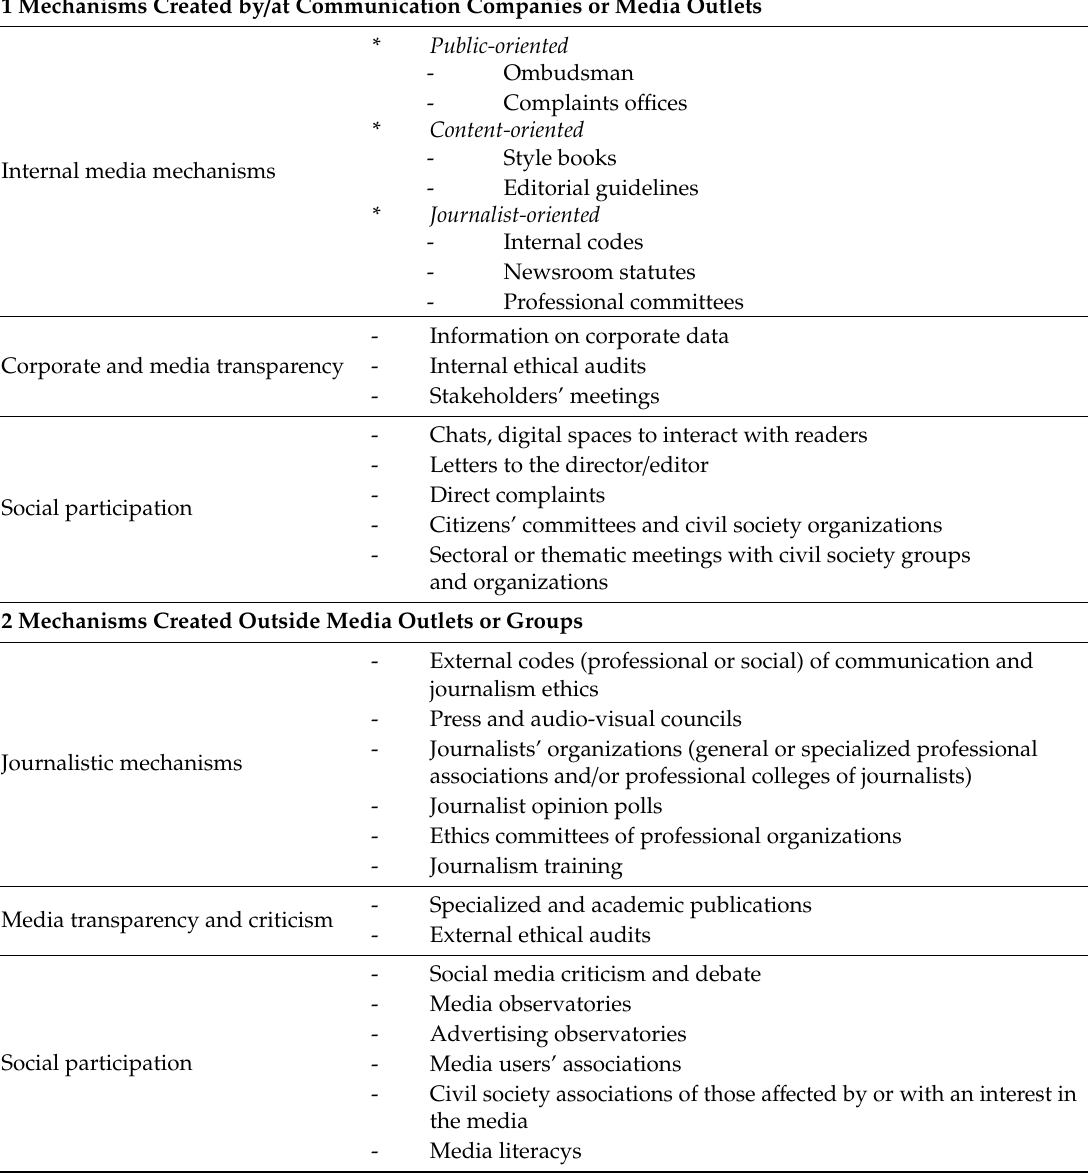
Table 2. Self-regulatory mechanisms for social